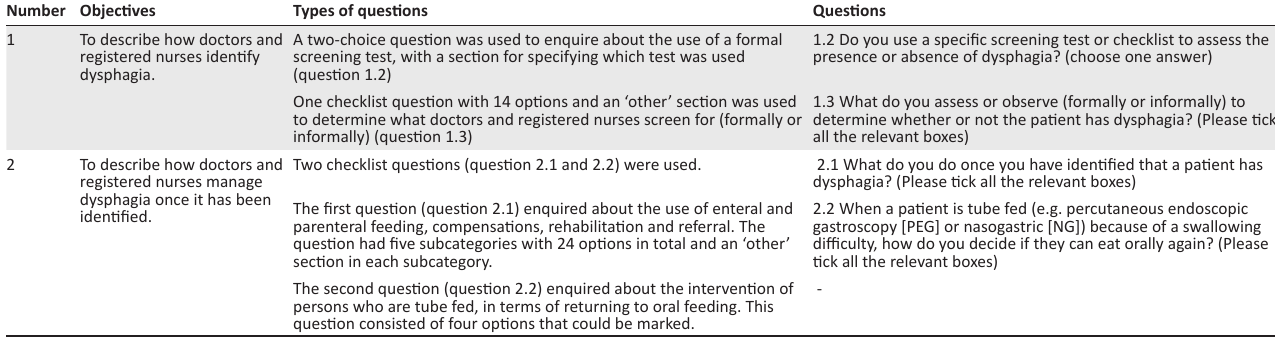
TABLE 1: Objectives and methods of development of the Dysphagia Management Questionnaire. Number